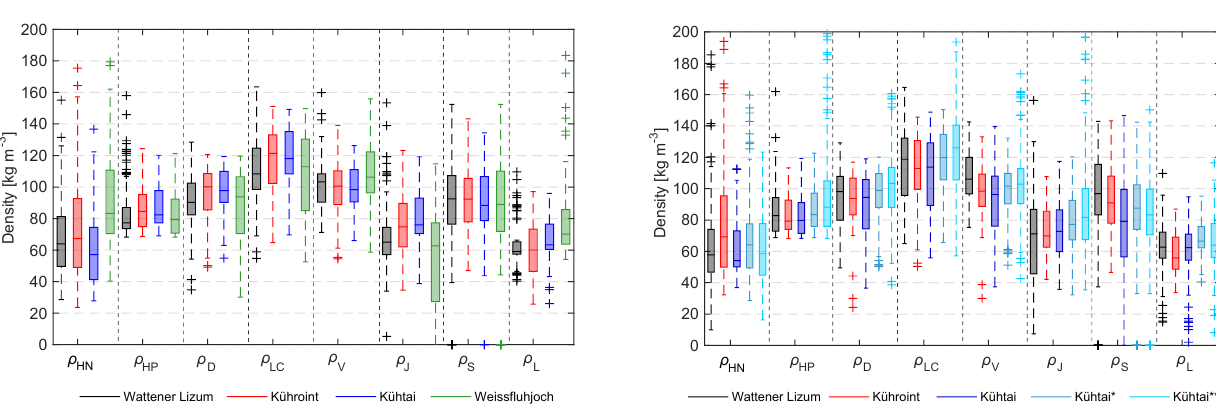
Figure 8. Box plots (median, 25 and 75% percentiles, 1.5 × interquartile ranges, outliers) of calculated new snow densi- ties ( ρ HN ) based on observations and densities calculated using pa- rameterizations developed in previous studies (Eqs. 3–9) at three stations within period 2 (1 October 2011–1 October 2013) and at Kühtai station within period 3 (index ∗ , 1 October 1999–30 Septem- ber 2011) and period 4 (index ∗∗ , 27 February 1987–30 Septem- ber